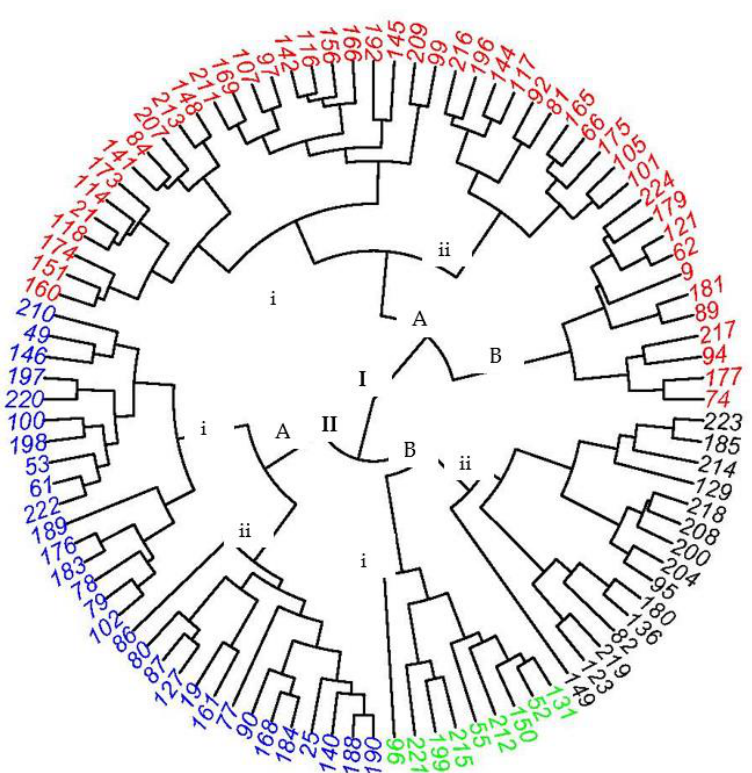
Figure 1. Dendrogram of 100 bambara groundnut accessions based on phenotypical characteristics combined for three trials. The main clusters were represented using uppercase roman numerals (I and II), the sub-clusters were represented using uppercase alphabet letters (A and B), and the sub-sub clusters were represented using lowercase roman numerals (i and ii).